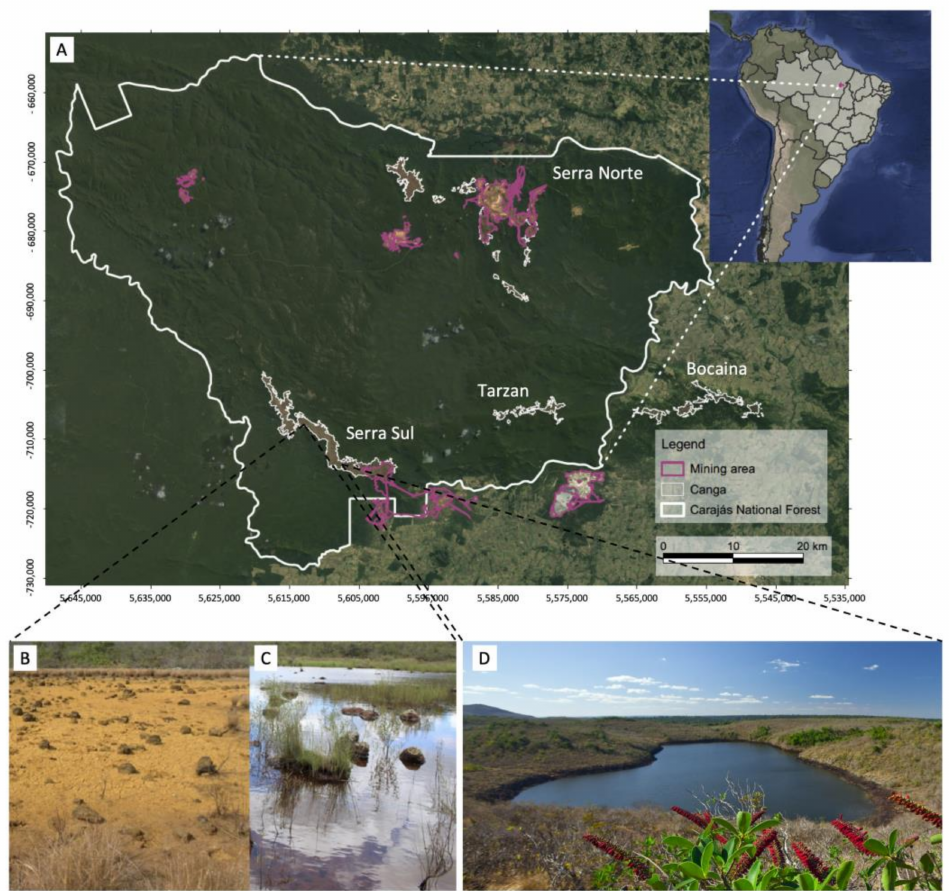
Figure 1. Map of the Caraj á s National Forest and the sites where I. serracarajensis and I. cangae were collected. ( A ) The mining areas and the four iron-rich mountain outcrops harboring the canga ecosystems of Caraj á s: Serra Norte, Serra Sul, Tarzan, and Bocaina. Details of the temporary ponds (sites with I. serracarajensis ) during the ( B ) dry and ( C ) rainy seasons and ( D ) a permanent lake where I. cangae is